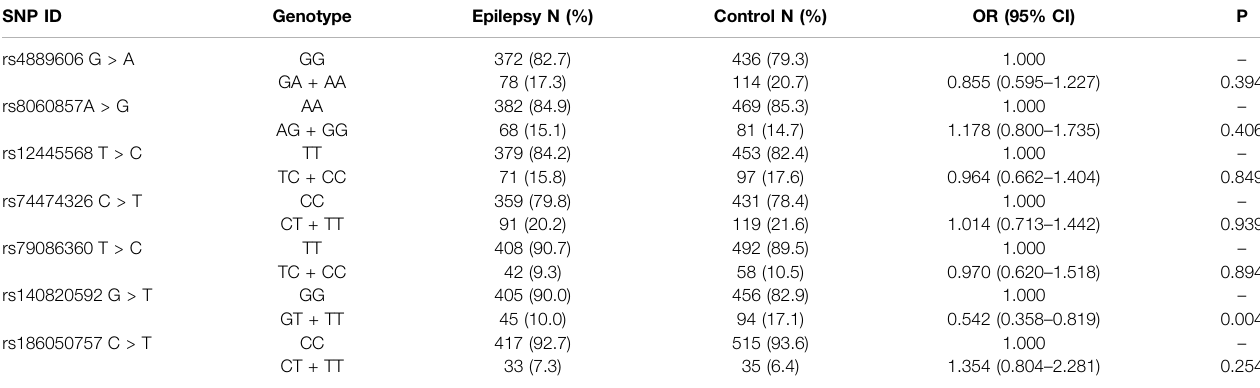
TABLE 4 | Associations between STX1B SNP genotypes and epilepsy.